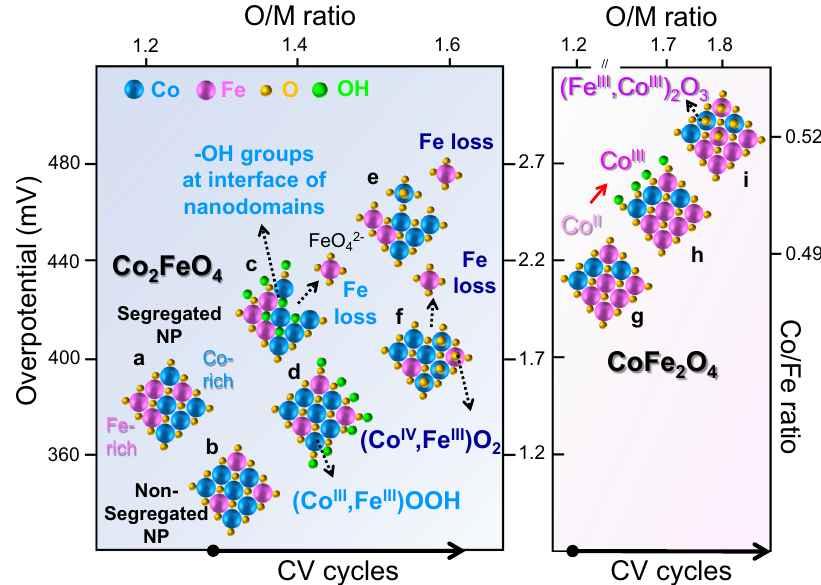
Fig. 8 Schematic diagram of the gradual changes of Co 2 FeO 4 and CoFe 2 O 4 with increasing CV cycles under the OER conditions. The pristine Co 2 FeO 4 is comprised of a segregated Co 2 FeO 4 with Fe-rich and Co-rich nanodomains and b non-segregated Co 2 FeO 4 nanoparticles. The interface between Co-rich and Fe-rich nanodomains of segregated Co 2 FeO 4 is thought to provide trapping sites for c hydroxyl groups, thereby contributing to a lower overpotential of pristine Co 2 FeO 4 than that of g pristine CoFe 2 O 4 . At the beginning of electrolysis, concurrent structural transformation to c , d Co III OOH and c , e , f Fe dissolution occurred for both segregated and non-segregated Co 2 FeO 4 . In addition, f stable (Co IV , Fe III )O 2 is formed on the surface of Co 2 FeO 4 , further degrading its activity. The OER activity of CoFe 2 O 4 also decreases as the number of CV cycles increases, which is due to h oxidation of Co(II) to Co(III) and i the formation of the stable (Fe III , Co III ) 2 O 3 phase on the surface. (The left axis is overpotential at 10 µ A/cm 2 , the top axis is the average O/M ratio, the right axis is the average Co/Fe ratio, and the bottom arrows point to the trend of increasing CV